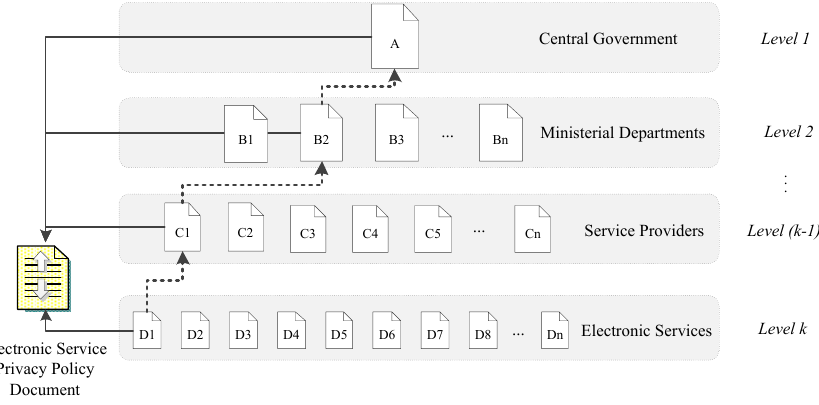
Figure 2. Electronic Service Privacy Policy